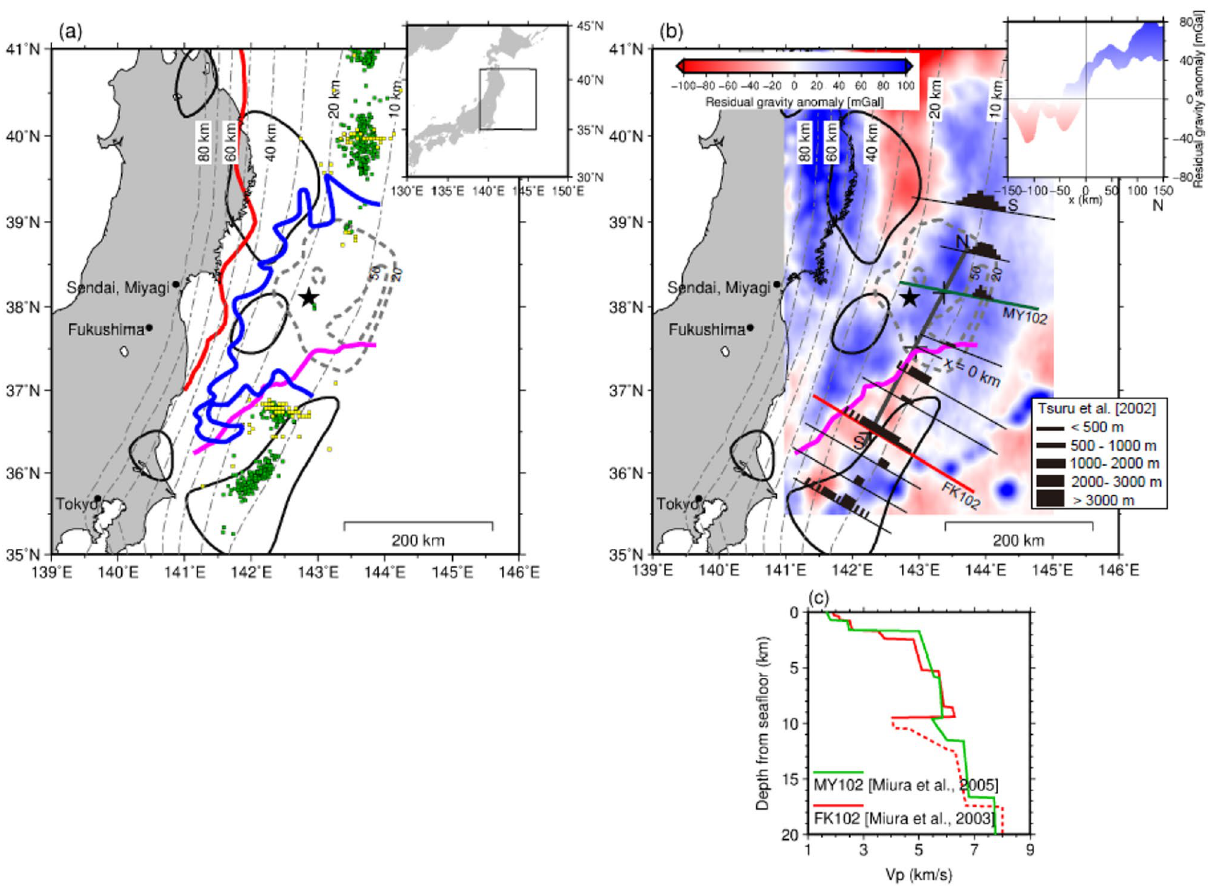
Figure 1. ( a ) Distributions of seismic/aseismic events along the Japan Trench. The black solid lines indicate the cumulative distribution of the estimated postseismic slip (> 0.4 m) for 0.6 years of the 2011 Tohoku-Oki earthquake 7 . The grey dashed contours represent the coseismic slip distribution (> 20 m, > 50 m) of the Tohoku- Oki earthquake 3 . Green squares indicate tremors 10 . Yellow squares denote very-low-frequency earthquakes 10 . Red and blue curves indicate the down-dip limit of the interplate earthquake distribution 53 and the outer edge of the large-slip zone during the mainshock rupture 16 , respectively. The black star indicates the hypocentres of the Tohoku-Oki earthquake. The thin, black, dashed contours extending in the north–south direction indicate the depth (km) to the upper surface of the descending plate 41 . The magenta line is the forearc segment boundary 15 . The rectangle in the inset represents the location of the study area. ( b ) Colours indicate the residual gravity anomaly (modified from Bassett et al. 15 ). The magenta line is the same as in ( a ). The black bars indicate the low- velocity sedimentary units observed on MCS sections 18 . Green and red lines with subscripts MY102 and FK102 indicate survey lines 18,31,32 . Crosses on these lines indicate locations at which velocity profiles are shown in ( c ). The inset shows the profile of the residual gravity anomaly along the thick black line S–N (along the contour of approximately 13 km depth). ( c ) Seismic velocity profiles. Green and red lines indicate the P-wave velocity (Vp) off Miyagi and Fukushima (crosses on MY102 and FL102 in b) estimated from marine surveys 31,32 . The vertical axis indicates the depth from the seafloor. The lateral axis indicates the Vp. The dashed lines indicate a lower velocity resolution. There is a low-velocity zone at a depth of 2–5.5 km (upper crust, lower sedimentary layer) and a depth > 10 km (channel layer) at the southern segment (green line). However, the Vp = 6 km/s layer is widely distributed at the ~ 5.5–10 km depth, where it is directly above the plate interface of the middle and southern segments of the Japan